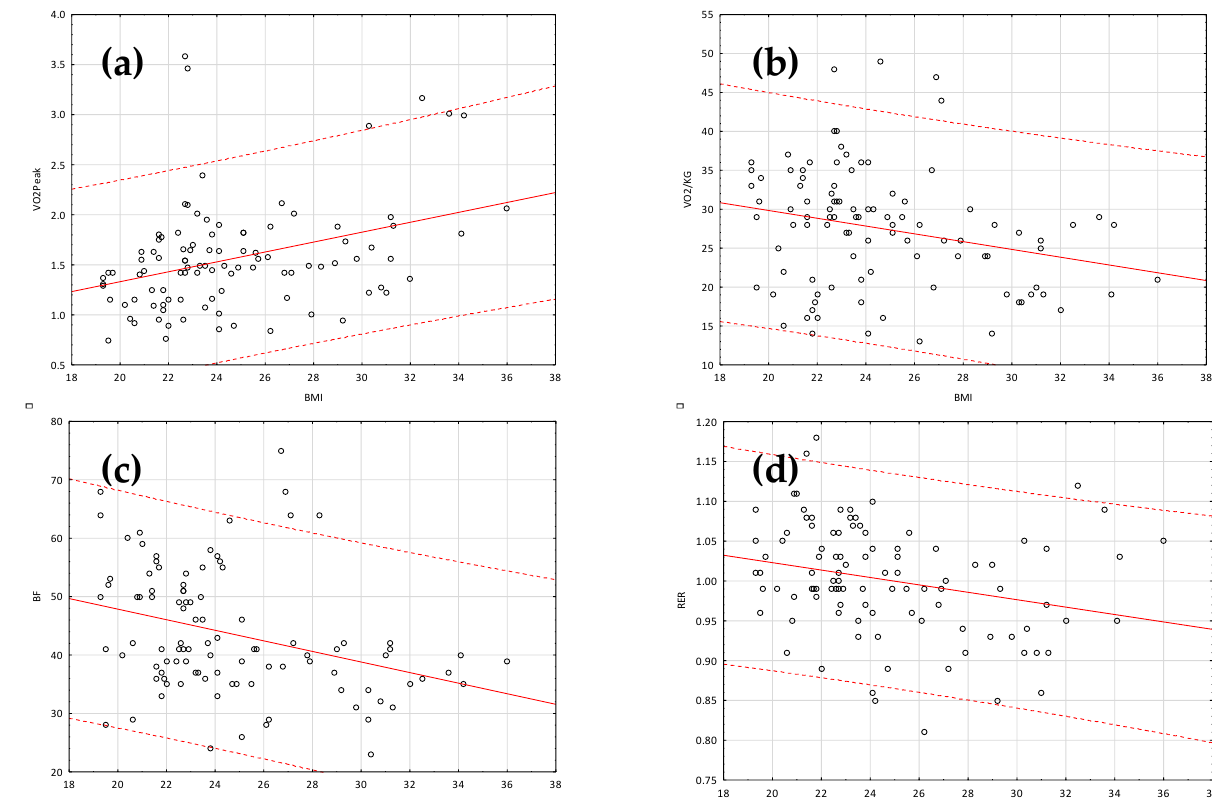
Figure 1. BMI as a predictor of VO 2peak ( a ) and VO 2peak/kg ( b ), BF ( c ), RER ( d